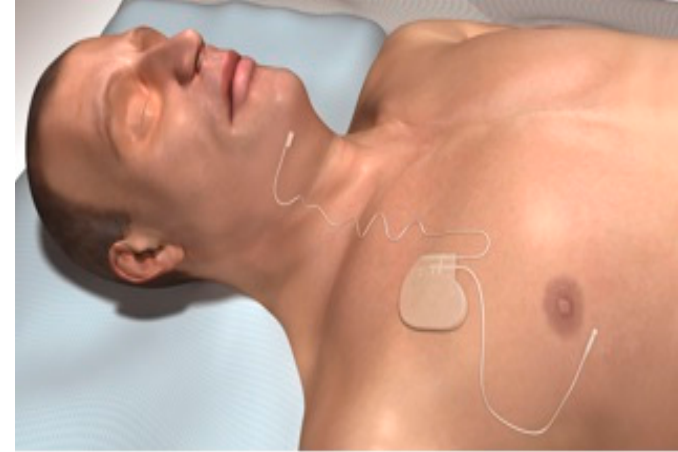
Figure 3. The Inspire system (Maple Grove, MN, USA).